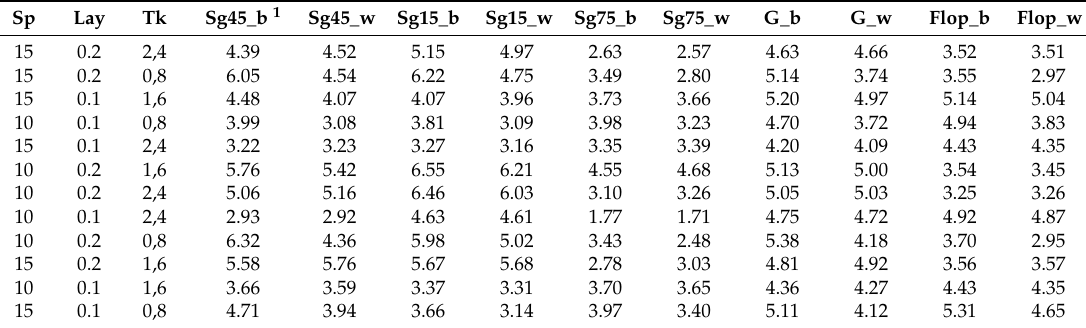
1 All the measurements taken on black (b) and white (w) backgrounds.